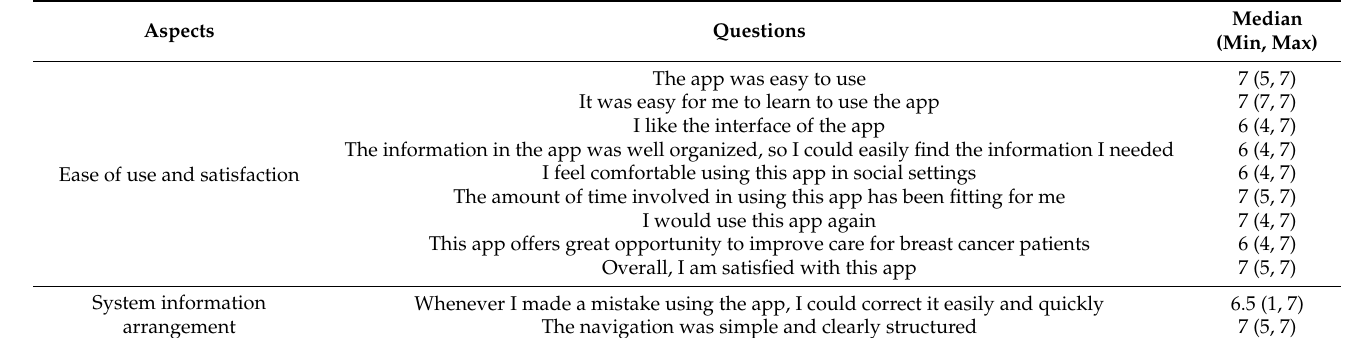
Table 2. Opinion on using the application (Likert scale ranges from 1 = totally disagree to 7 = totally agree) ( n =